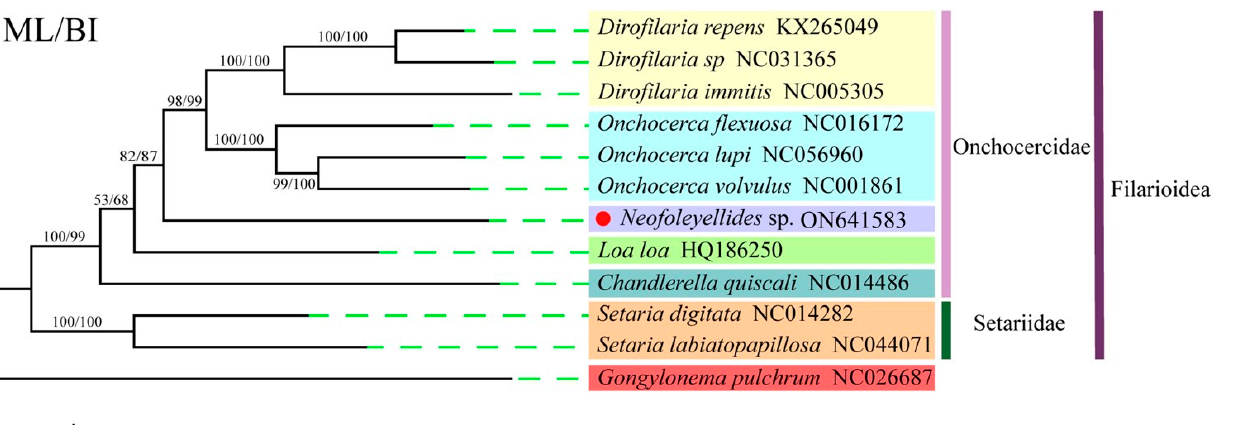
Figure 5. Nucleotide diversity ( π ) of the mitogenomes obtained in this study. The blue line indicate nucleotide diversity values based on the evaluation of sequences from B. malayi , D. repens , O. flexuosa , and A. viteae . The π values (plotted on the y-axis) were calculated in a 200 bp sliding window with 25 bp steps. The lengths of the aligned sequences of the two evaluated groups are plotted on the x-axis. The limits of each gene are indicated above the graph. Vertical red bars represent tRNAs, orange rectangles represent PCGs, and cyan bars represent rrn L and rrn S.